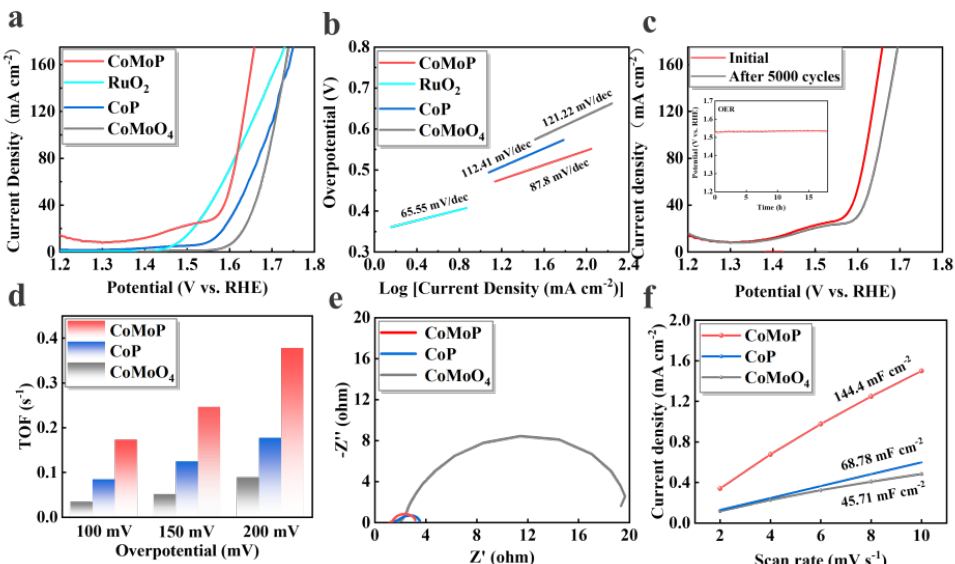
Figure 4. ( a ) LSV curves of RuO 2 , CoMoP, CoP, and CoMoO 4 NFs. ( b ) Corresponding OER Tafel plots. ( c ) The stability of the CoMoP NFs for 5000 CV cycles and chronopotentiometry testing at a current density of 10 mA cm − 2 . ( d ) Comparison of TOF values under different overpotentials for CoMoP, CoP, and CoMoO 4 NFs. ( e ) EIS pattern of the above catalysts. ( f ) The plots of the current density versus the scan rate of the above electrocatalysts.